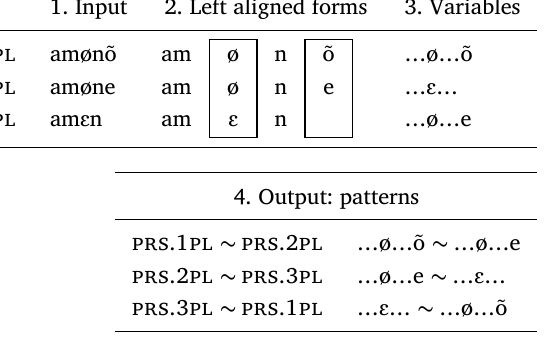
1. Input 2. Left aligned